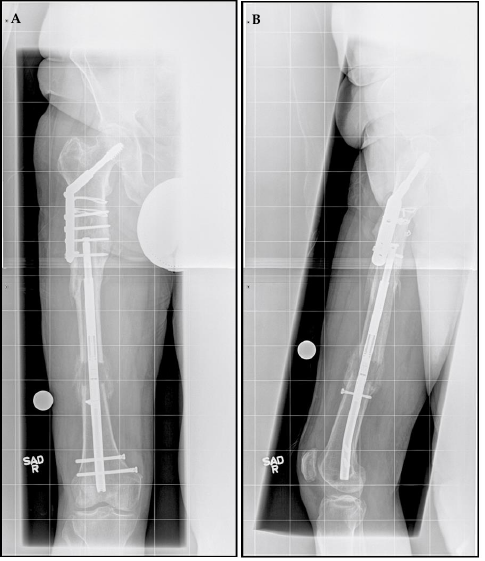
Figure 3. Post-traumatic femoral lengthening in a 71-year-old male patient after the distraction phase. ( A ) Antero-posterior and ( B ) lateral of the right femur after the completion of 3 cm distraction with Precice MILN. Gray dots on the bottom represent X-Ray calibration spheres.